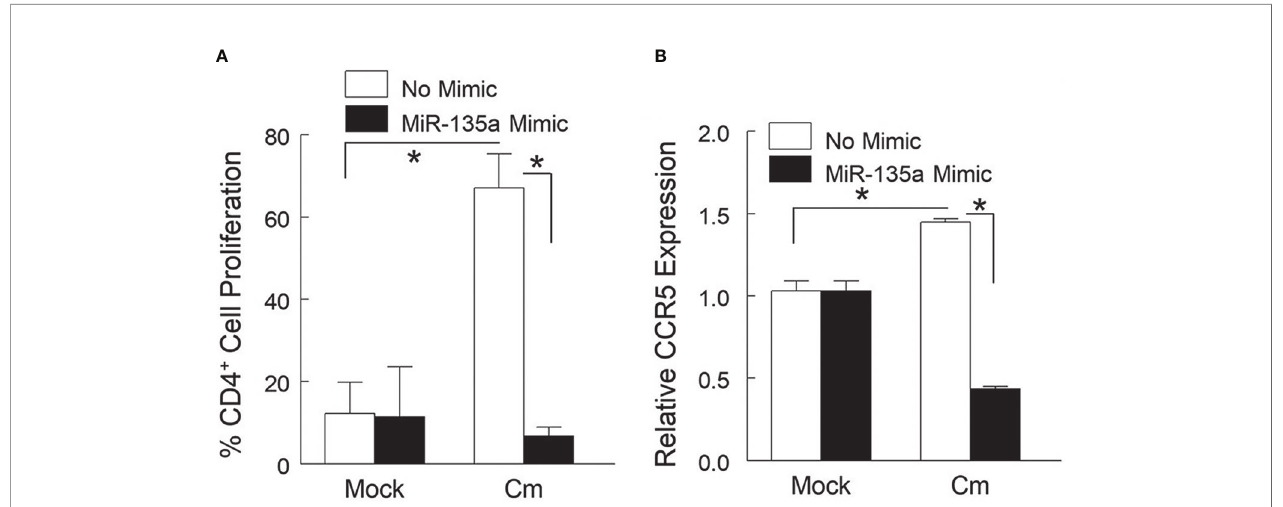
FIGURE 2 | miR-135a affects dendritic cell mediated Cm-primed CD4 + T cell proliferation and CCR5 gene expression. Bone marrow derived dendritic cells (BMDC) were stimulated with media alone, or media containing miR-135a mimic for 24 hours followed by exposure to Cm (MOI = 1). Cm primed BMDCs were co-cultured with splenic CD4 + T cells from day 6- post intravaginally challenged mice (5 x 10 4 IFU) or mock infected. (A) Effect of miR-135a mimic on CD4 + T cell proliferation. (B) Effect of miR-135a mimic on CCR5 gene expression. Data shown are representative of 3 experiments. *p < 0.05 Student t